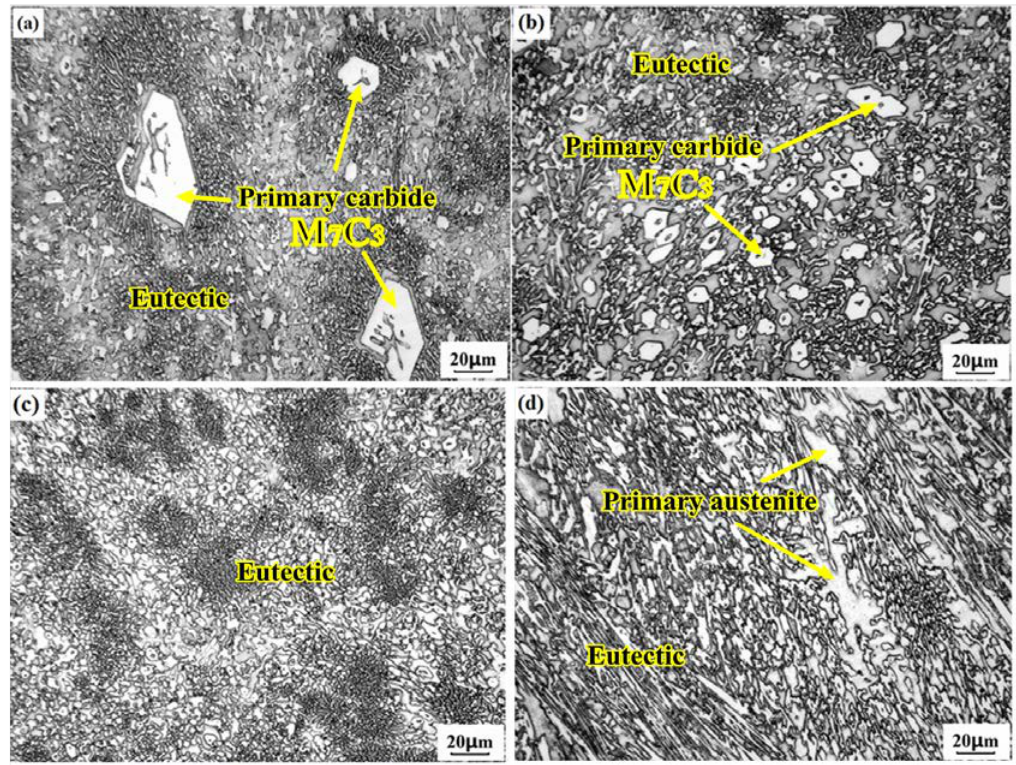
Figure 5. Microstructure of 3.6C-20Cr-Fe HCCI hardfacing layers with different V, ( a ) 0 V, ( b ) 0.83 V, ( c ) 1.50 V, ( d ) 2.32 V.